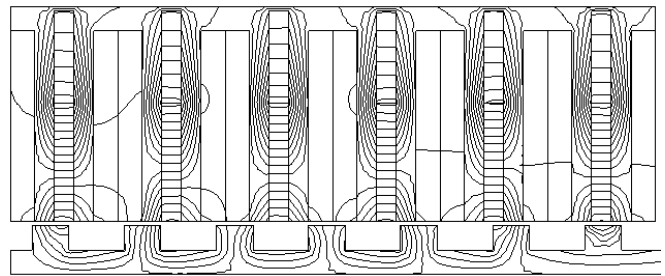
Figure 12. Flux line distribution of proposed design at initial